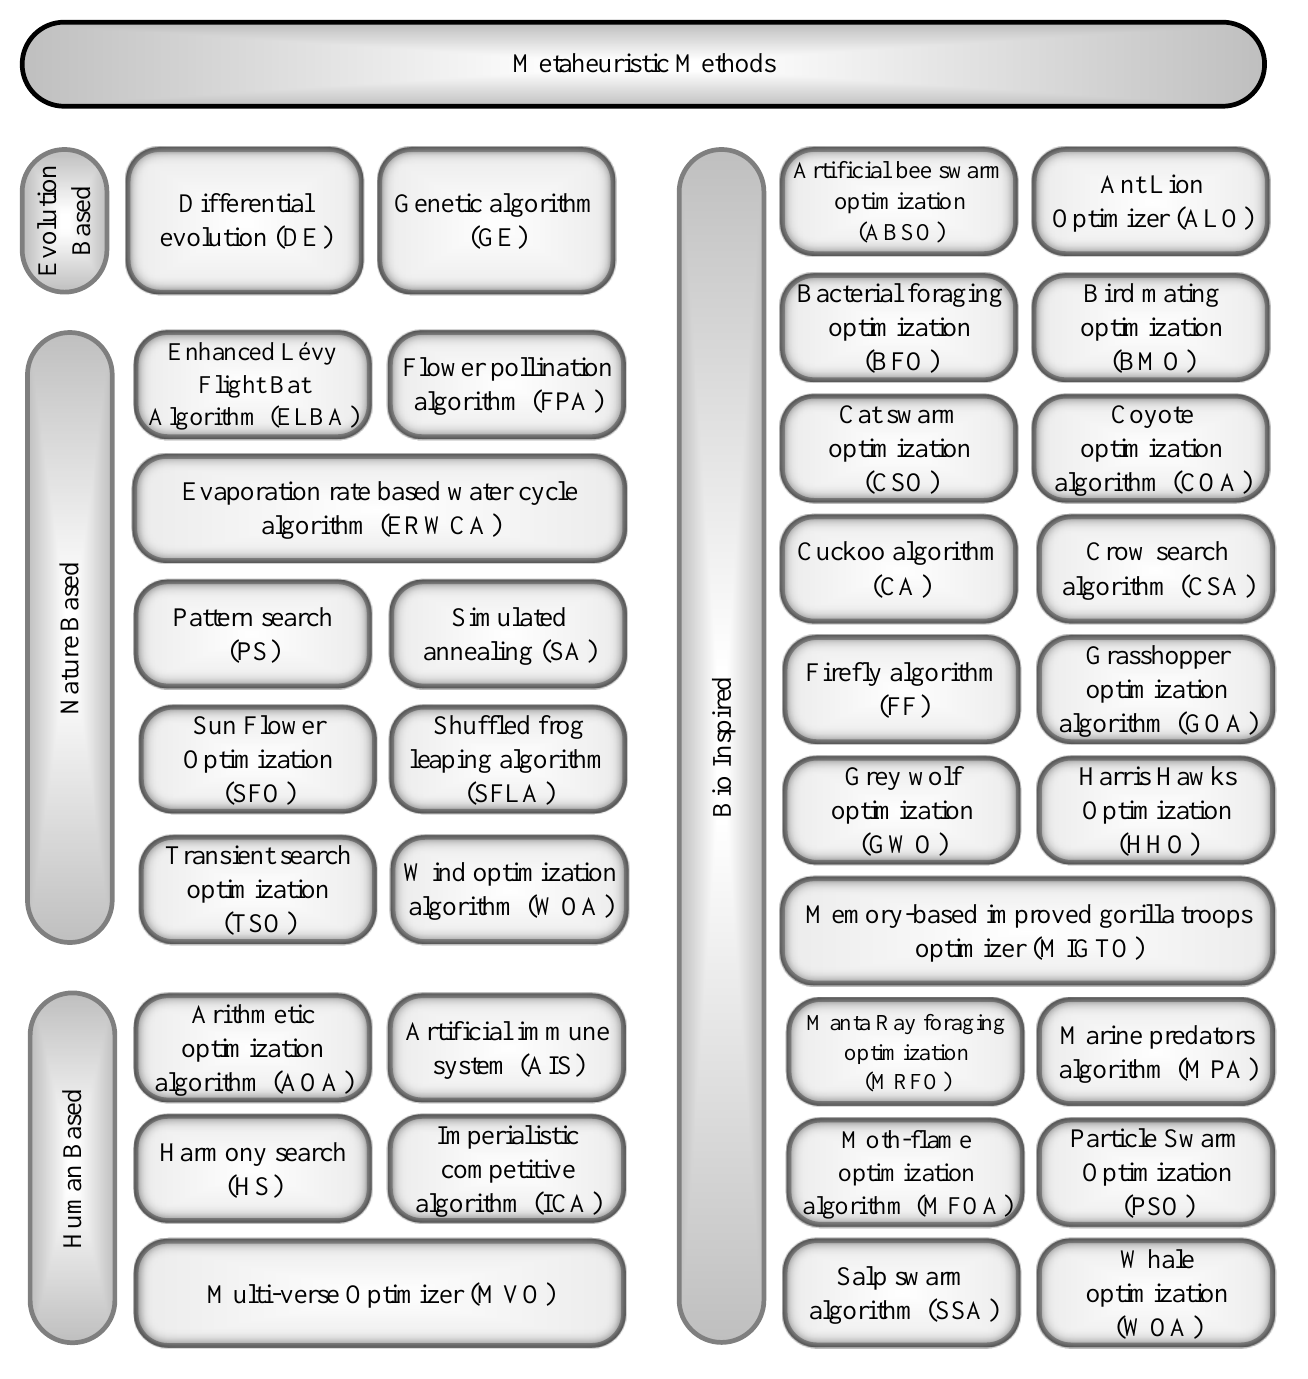
Figure 5. Categorizing metaheuristic algorithms used in PV parameter extraction.